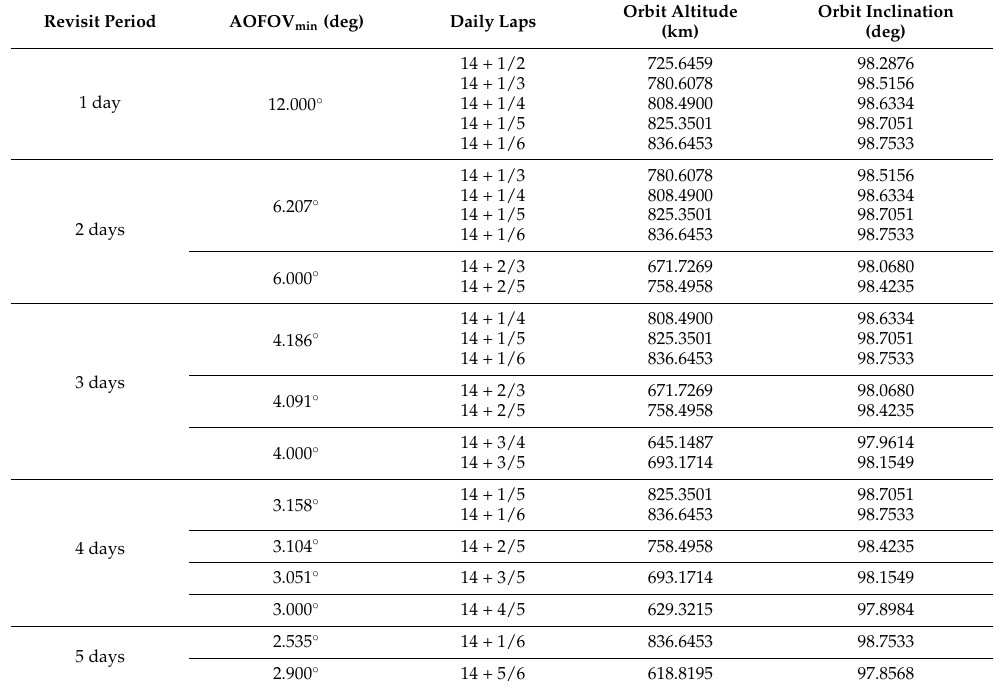
Table 3. The relationship between the revisit period, the along-orbit FOV, the daily laps, the orbit altitude, and the orbit